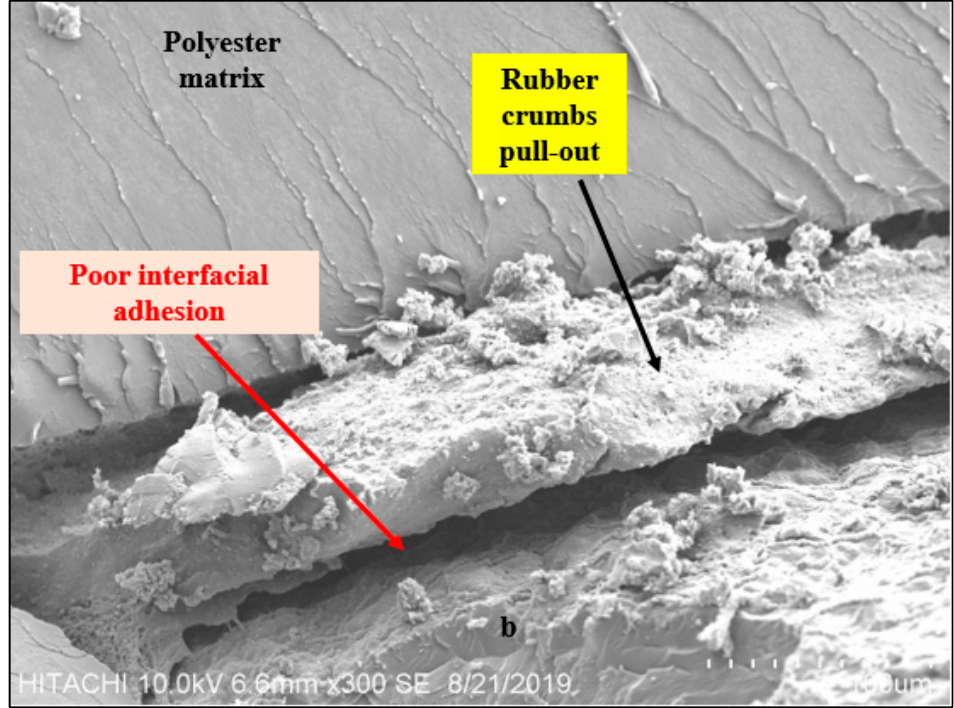
Figure 12. Tensile fracture micrograph of composites with 4% NaOH treated rubber crumbs.